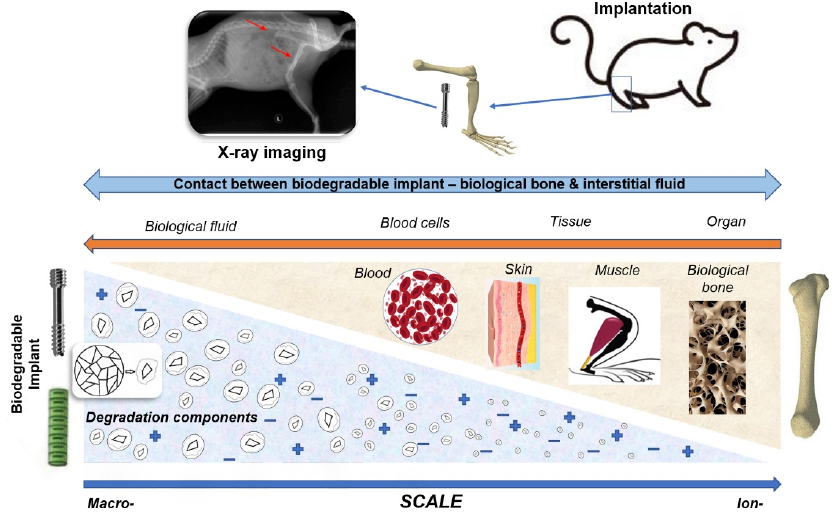
Figure 10. Mode of interaction of biodegradable materials in contact with the biological environment and implant response [82].